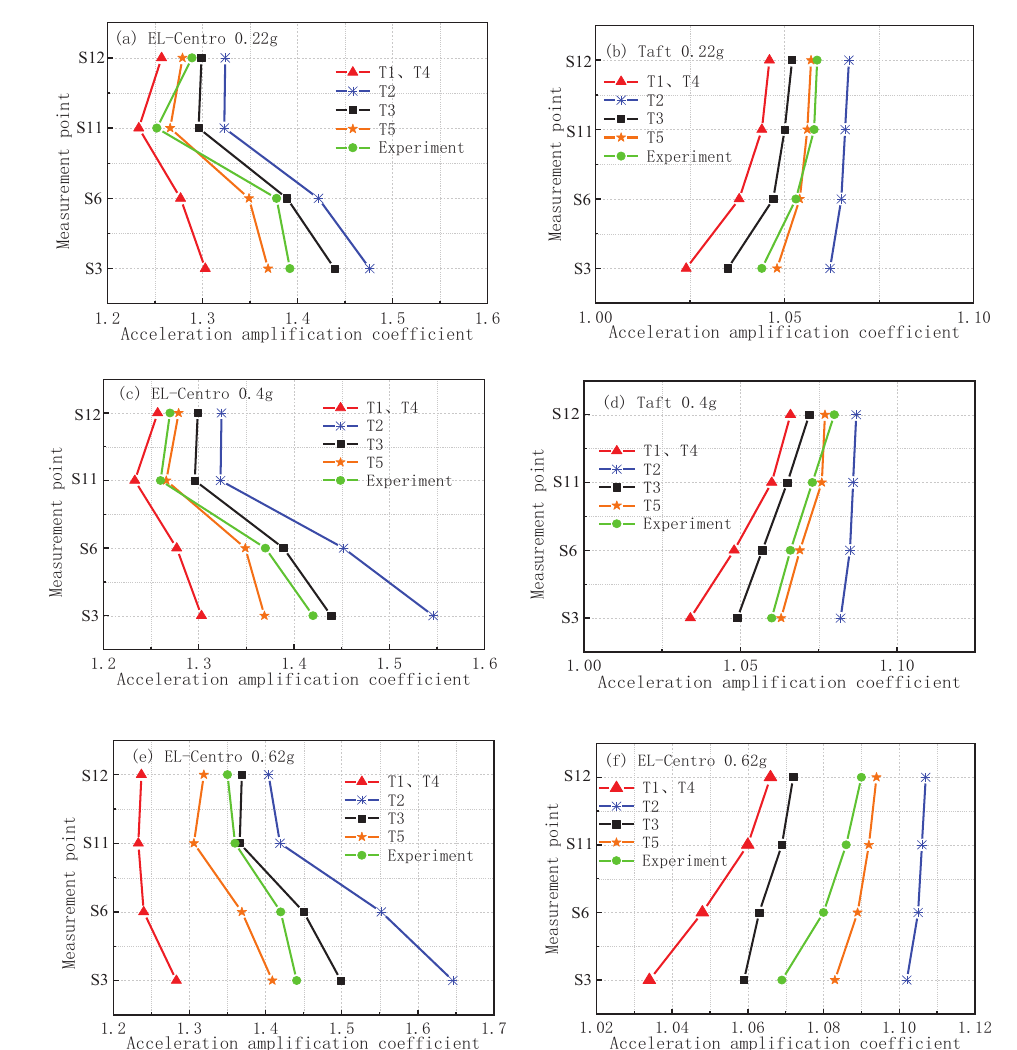
Fig. 6. Envelope curve of acceleration ampli fi cation coef fi cient with the seismic wave (0.22g; 0.4 g; 0.62